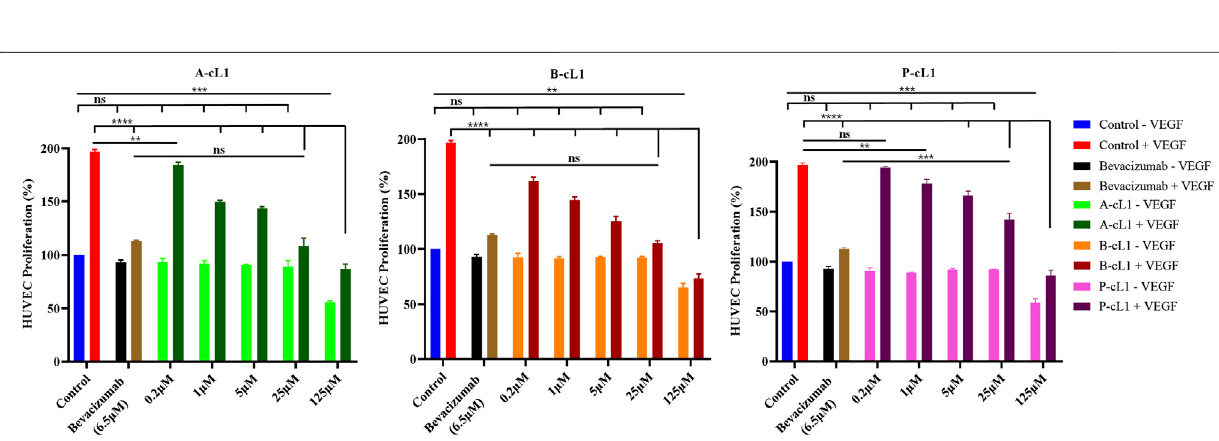
FIGURE 3 | Peptides A-cL1, B-cL1, and P-cL1 inhibit VEGF-A stimulated HUVECs proliferation. HUVECs were cultured in serum-free medium without or with 0.2 μ g/mlVEGF-A(negativecontrol-VEGF and positivecontrol+VEGF), treatedwith6.5 μ MbevacizumabwithoutorwithVEGF;treatedwith0.2, 1,5,25,and 125 μ M ofA-cL1,B-cL1orP-cL-1withoutorwithVEGF.Therelativecellproliferation(%)wereanalyzedwithGraphPadPrism8(mean ± SEMofthreeindependentexperiments), compared to the control group in one-way ANOVA statistical analysis. * p < 0.05, ** p < 0.01, *** p < 0.001, **** p < 0.0001, “ ns ” meaning non-signi fi